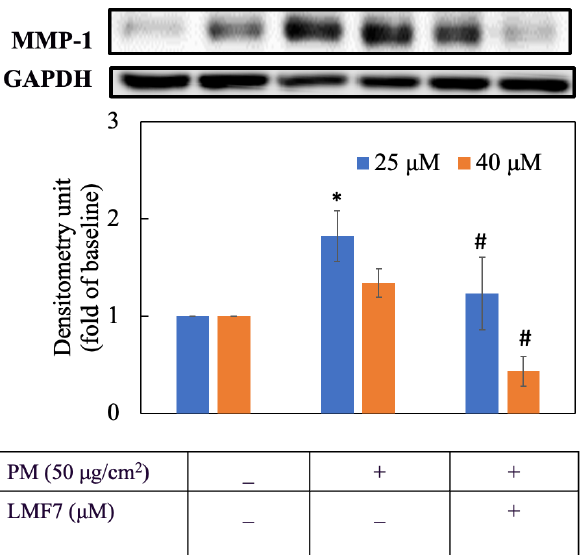
Figure 13. MMP-1 protein expression. Cells were pre-incubated with blank liposome or liposomal morin formulation 7 for 3 h and then treated with PM for 6 h. +, − mean with or without exposing to PM or LMF7, respectively. Data were presented as mean ± SD and from triplicate experiments. *, # indicates a statistically significant difference with control group (without treating PM and LMF7) and PM group (only treating LMF7), respectively, p < 0.05.